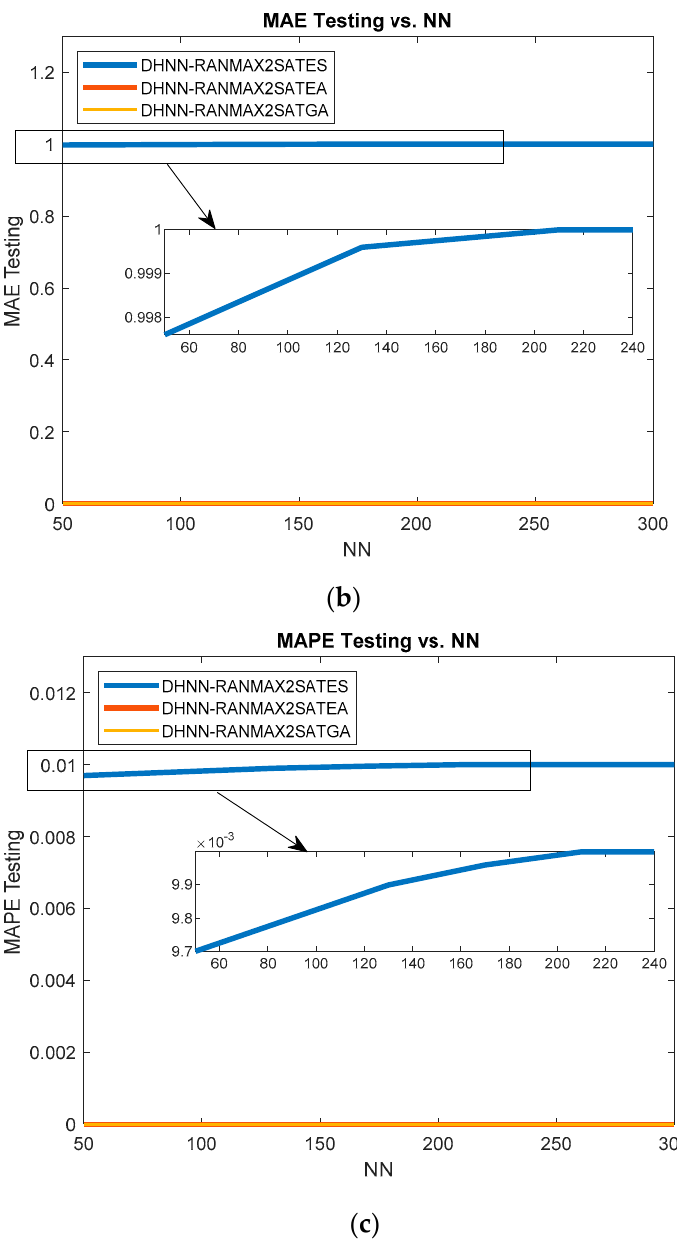
Figure 4. ( a ) RMSE testing for DHNN-RANMAX2SAT; ( b ) MAE testing for DHNN-RANMAX2SAT; ( c ) MAPE testing for DHNN-RANMAX2SAT.